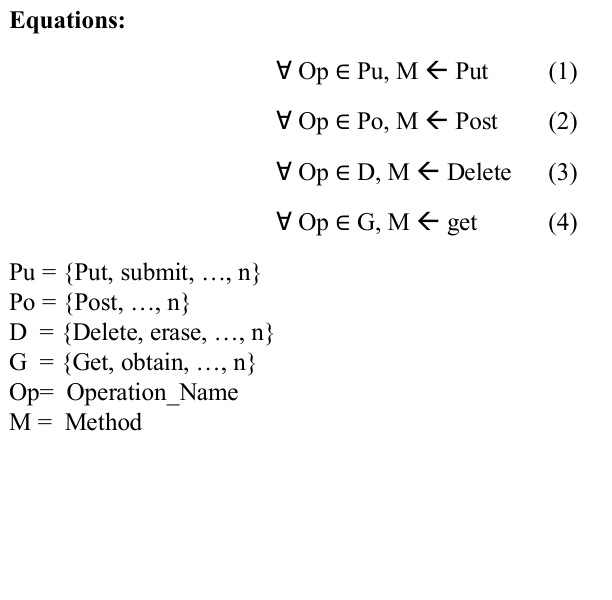
Fig. 4. Conversion algorithm from WADL to